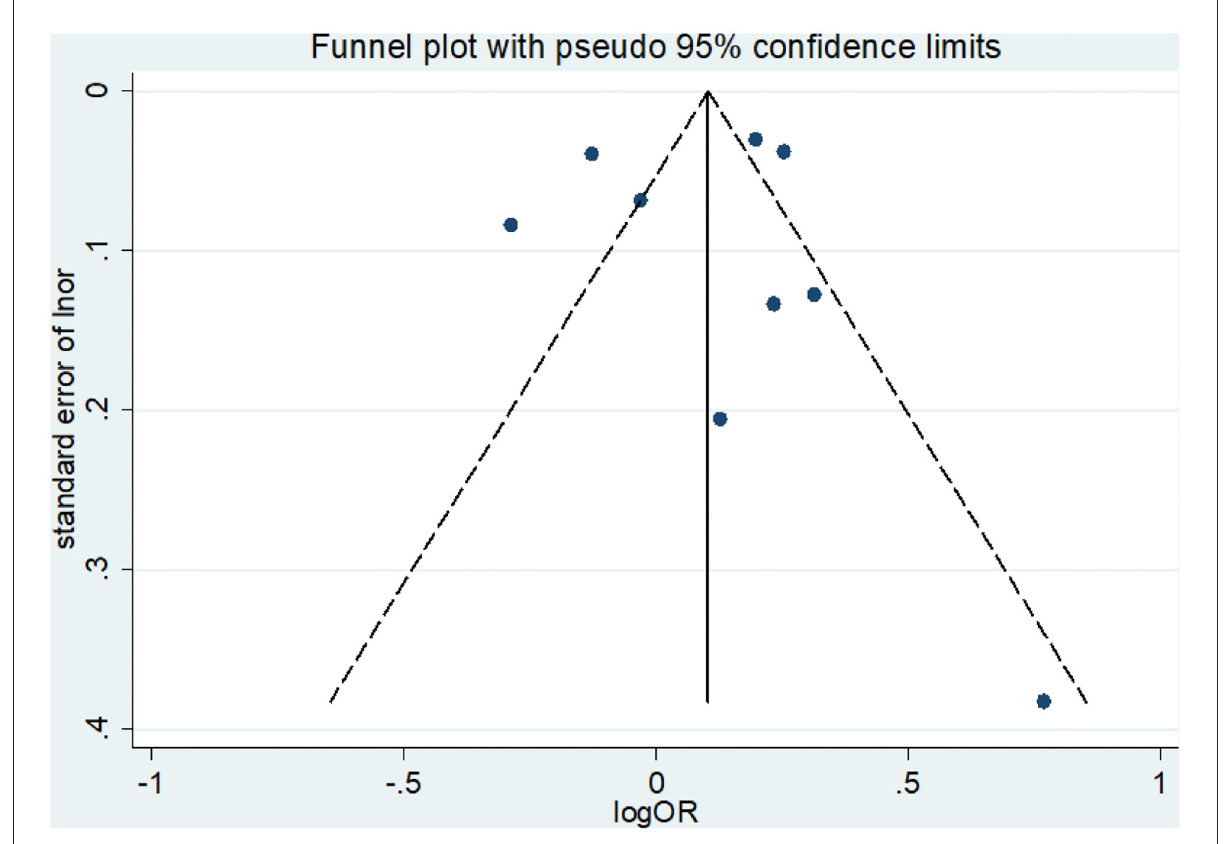
FIGURE3 Funnel plot for studies of daytime napping in relation to the risk of